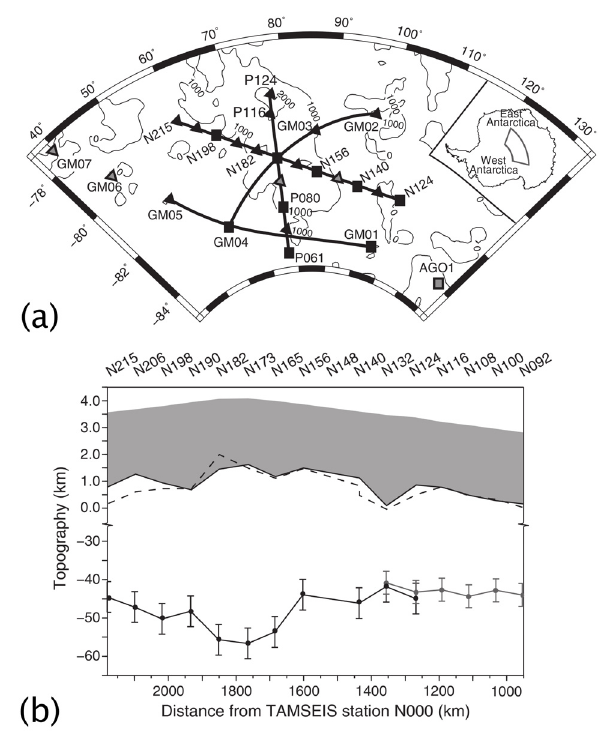
Figure 11. Crustal structure of East Antarctica (after Hansen et al. [2011]). (a) TAMSEIS (N215 to N124), and GAMSEIS stations. (b) Crustal structure derived from joint inversion of S-wave receiver functions and Rayleigh wave dispersion curves.